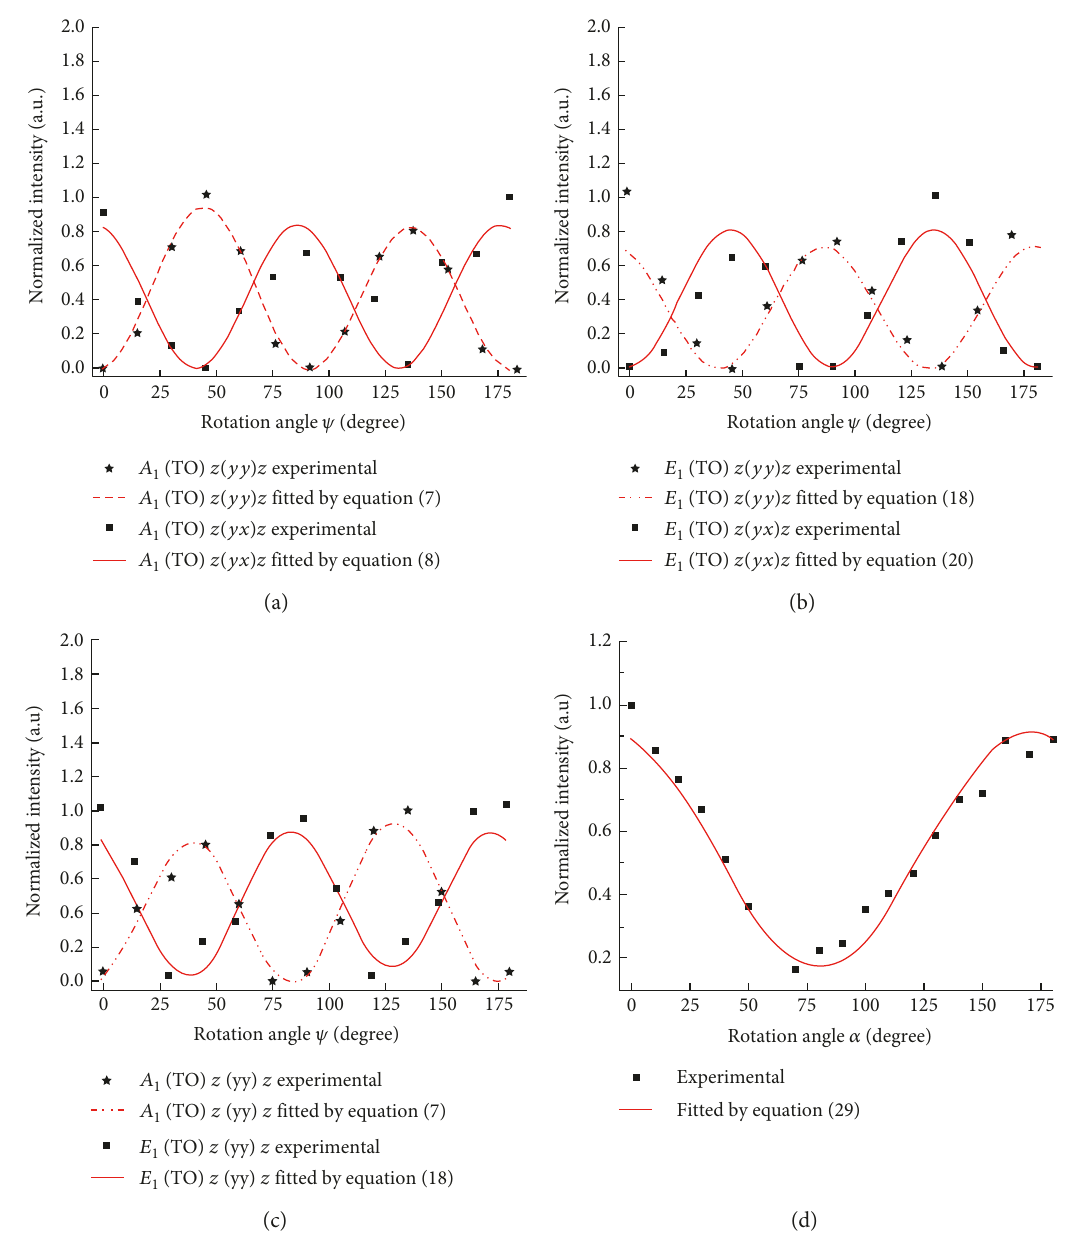
E Figure 3: Change of Raman intensities at (a) A 1 (TO) and (b) 1 (TO) bands of A-plane ZnO with the rotation angle intensities at A 1 (TO) and E 1 (TO) bands of M-plane ZnO under parallel polarization with the rotation angle ψ ; (d) change of intensities at E 2 (low) band of M-plane ZnO with the polarization direction of incident